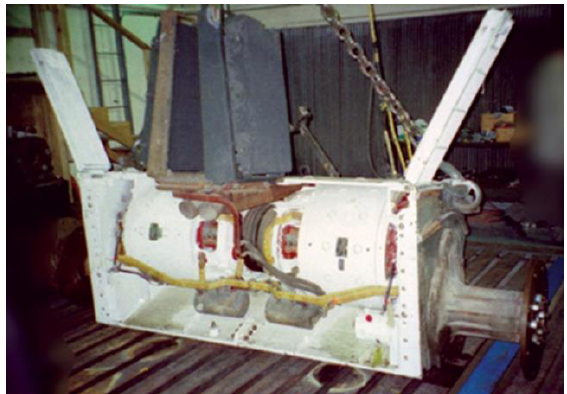
Fig. 11. The T-23 tank propulsion electric motors and reductors (photo by